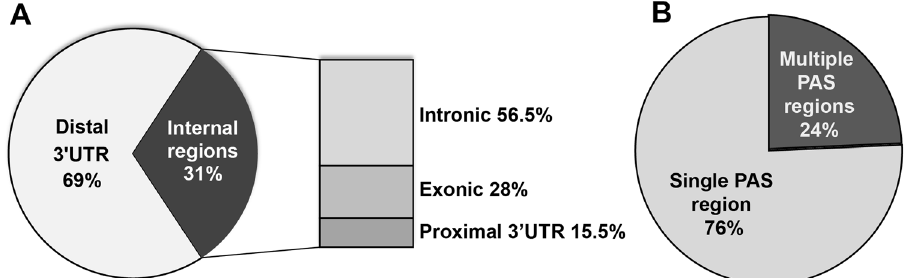
Fig. 2 Distribution of PAS locations. a Pie chart showing the percentage of PASs distribution in different regions of the gene (24,248; 6273; 3106, and 1724 PASs located at distal 3 ′ -UTRs, introns, exons, and internal 3 ′ -UTR, respectively). b Pie chart showing the percentage of genes containing PAS in single or multiple regions (3296 genes have multiple PAS regions and 10,355 genes have single PAS